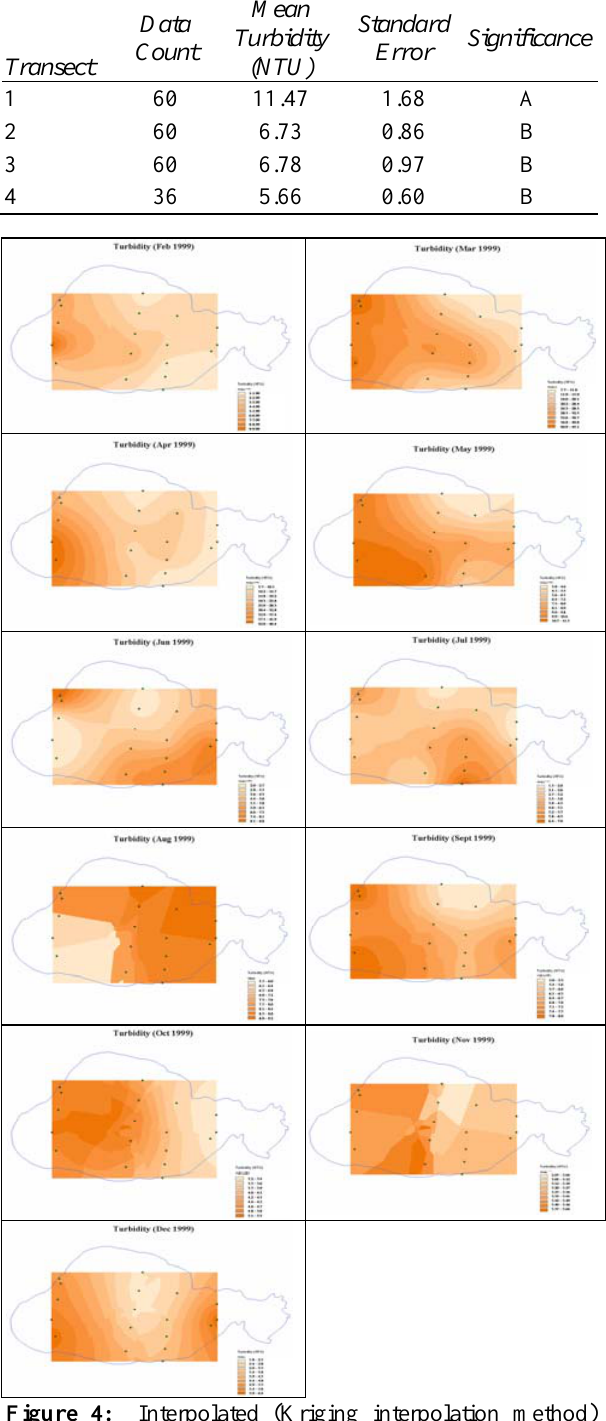
Figure 4: Interpolated (Kriging interpolation method) monthly turbidity values measured at the 18 sampling sites in 1999. The darker the color, the higher the turbidity.